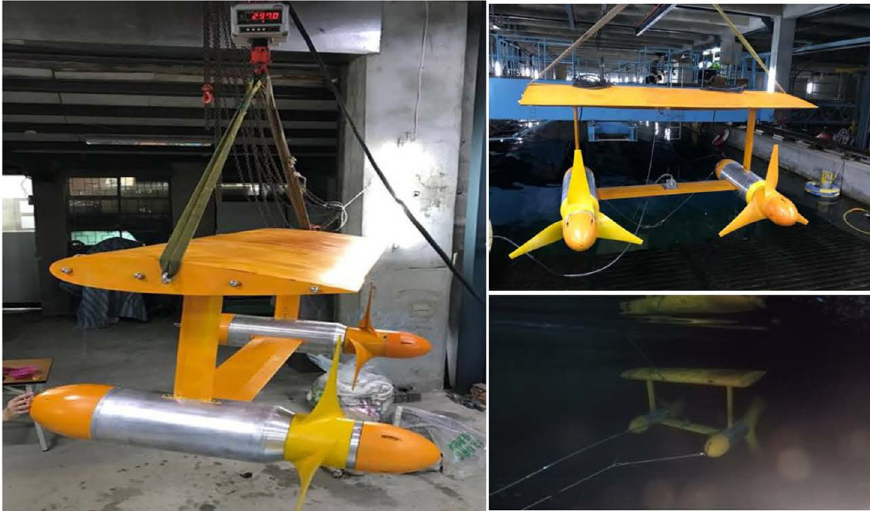
Figure 2. Prototype of Floating Kuroshio Turbine (FKT) [5].